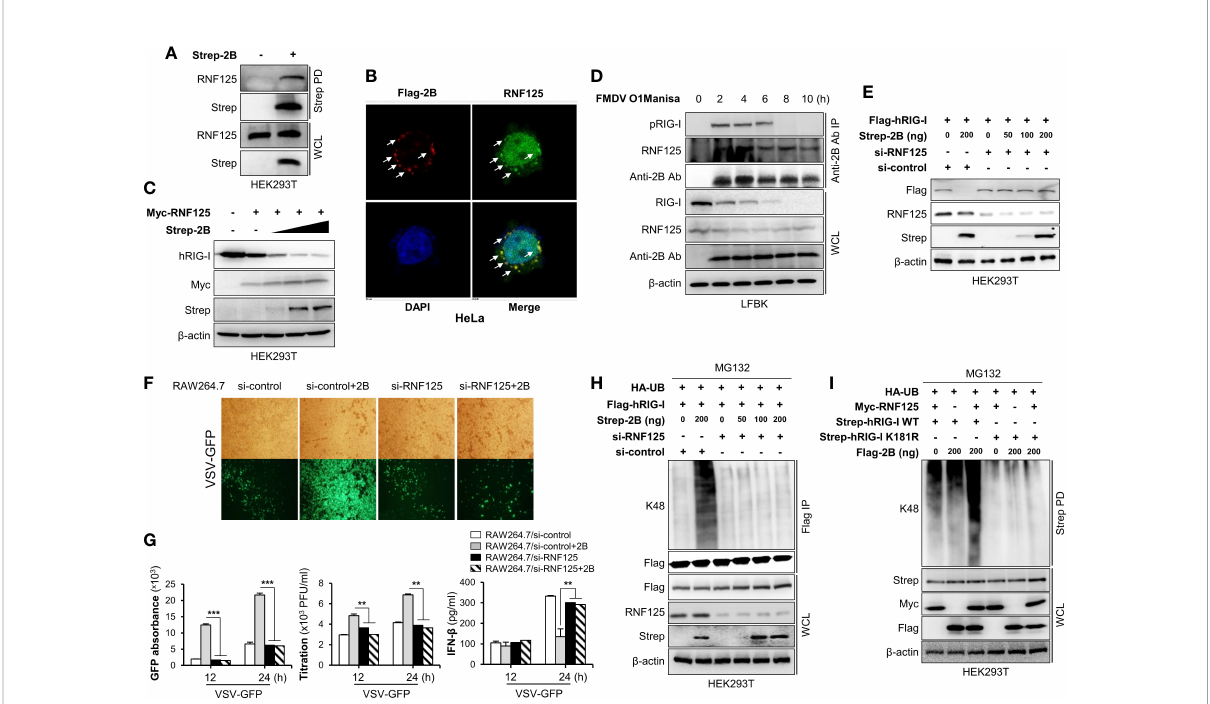
FIGURE 4 FMDV 2B recruit RNF125 to mediate K48-linked polyubiquitination and degradation of RIG-I. HEK293T cells were transfected with Strep-FMDV 2B. Cell lysates were subjected to Strep pull-down assay and immunoblotted with indicated antibodies (A) . HeLa cells were transfected with Flag-FMDV 2B, followed by confocal microscopy assay with anti-Flag (red) and anti-RNF125 (green) antibodies. Nuclei were stained with DAPI (blue) (B) . HEK293T cells were transfected with Myc-RNF125 together with increasing doses of Strep-FMDV 2B. The whole-cell lysate was immunoblotted with indicated antibodies (C) . LFBK cells were infected with FMDV O1Manisa strain, and cells were harvested after indicated time period post-infection. The whole-cell lysate was immunoprecipitated with FMDV 2B rabbit polyclonal antibody and immunoblotted with indicated antibodies (D) . HEK293T cells were transfected with si-control or si-RNF125 together with Flag-RIG-I and different doses of Strep-2B plasmids. The whole-cell lysate was immunoblotted with indicated antibodies (E) . (F, G) RAW264.7 cells were transfected with si-control or si- RNF125 together with Flag-FMDV 2B and infected with VSV-GFP. Viral replication was measured by fl uorescence microscopy, GFP absorbance, and plaque assay at indicated time points. The concentration of secreted IFN- b in supernatants was determined at 12 and 24 hpi by ELISA. HEK293T cells were transfected with si-control or si-RNF125 together with Flag-RIG-I, HA-ubiquitin, indicated doses of Strep-FMDV 2B and treated with MG132 6 hours before harvesting the cells. Whole-cell lysates were subjected to Flag-immunoprecipitation and immunoblotted with indicated antibodies (H) . HEK293T cells were transfected with Strep-RIG-I wild-type or RIG-I K181R mutant together with HA-ubiquitin, Myc-RNF-125, indicated doses of Flag-FMDV 2B and treated with MG132 6 hours before harvesting the cells. Whole-cell lysates were subjected to Strep pull-down and immunoblotted with indicated antibodies (I) . Results representative of at least two independent experiments, each with similar results, and the values are expressed as mean ± SD of three biological replicates. Student ’ s t-test; **p < 0.01; ***p <